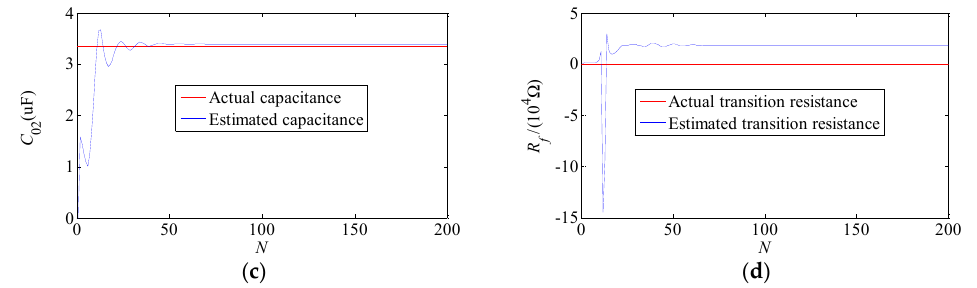
Figure 5. Estimated capacitances and transition resistances of feeder 1 and feeder 2 for a single-phase HIF in K1 point. ( a ) Estimated capacitance of feeder 1; ( b ) Estimated transition resistance of feeder 1; ( c ) Estimated capacitance of feeder 2; and ( d ) Estimated transition resistance of feeder 2.